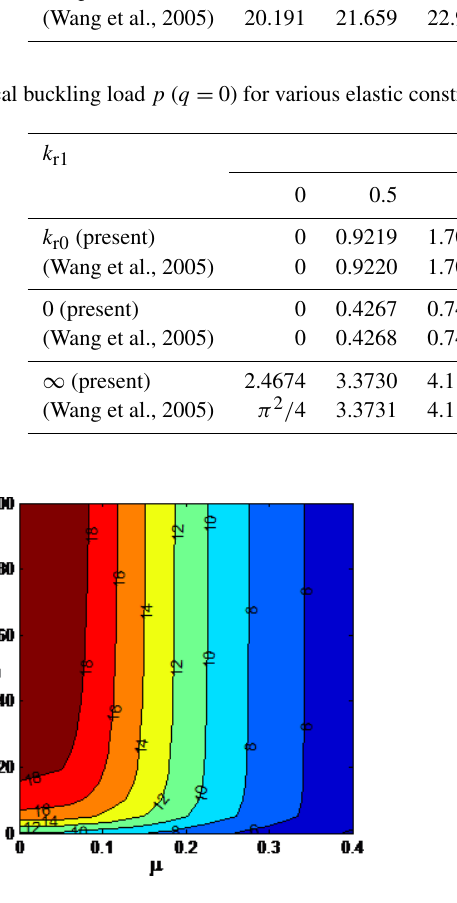
results for uniformly distributed axial load q are shown in Fig. 3. The trends are the same as the concentrated load